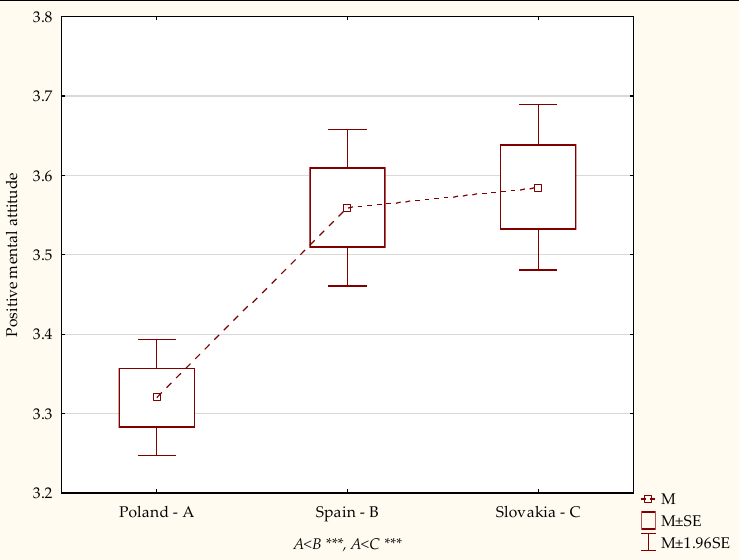
Figure 3. Intensity of positive mental attitude – diversity of scores. Statistically significant: *** p < 0.001.